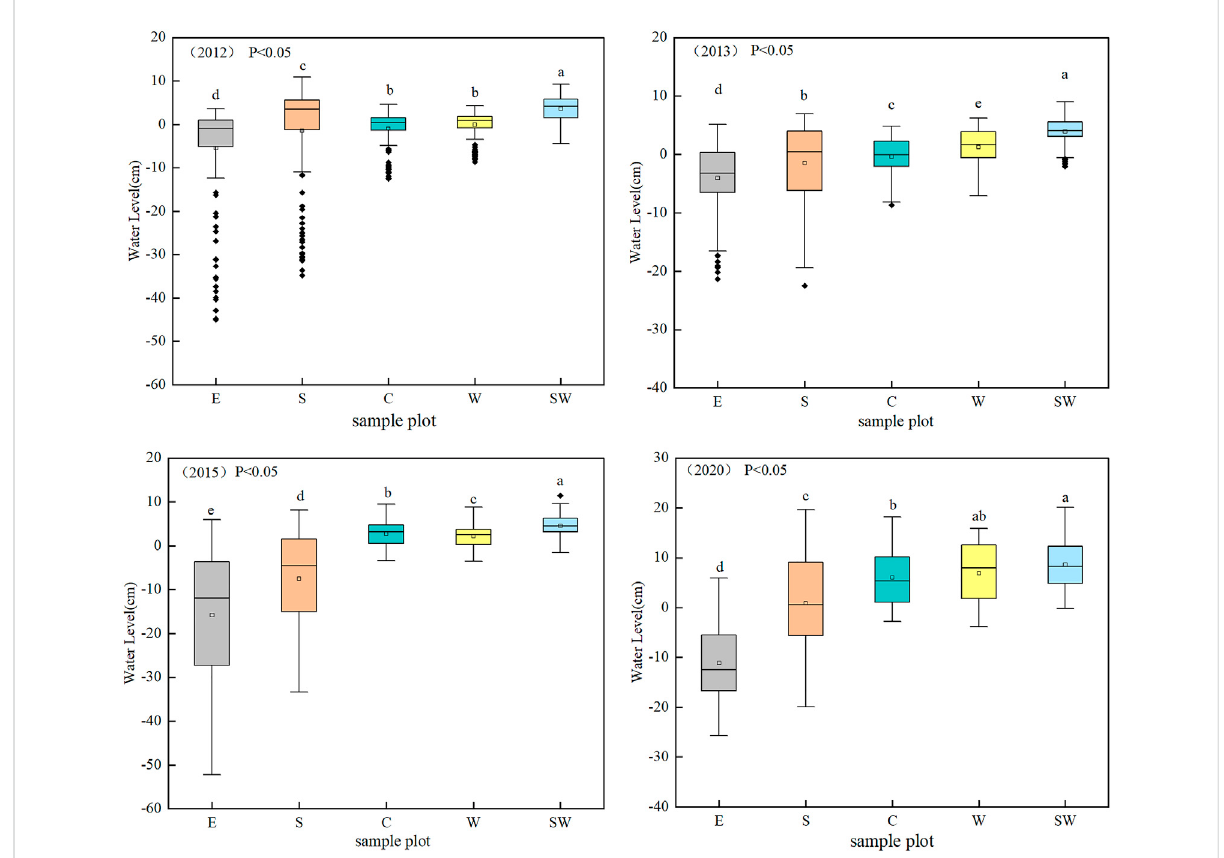
FIGURE 2 Boxplots of water level in various sample plots. Different lowercase letters indicate signi fi cant differences ( p <